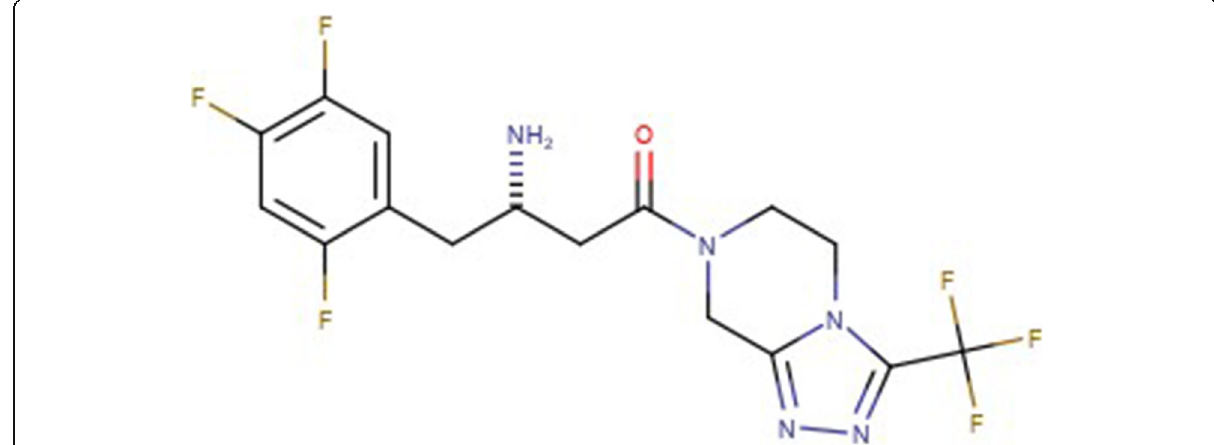
Fig. 1 Chemical structure of sitagliptin